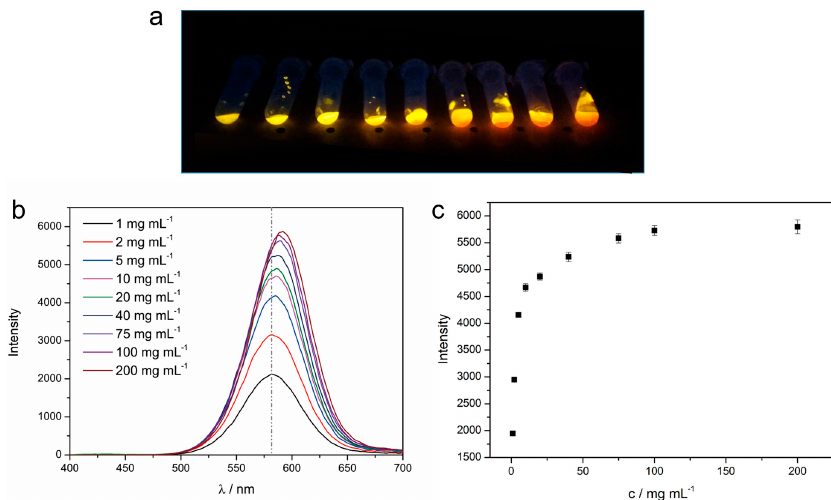
Figure 2. The relationship between fluorescence property and its concentration of HEMA-Ad/ β CD- CdTe. ( a ) Photograph of HEMA-Ad@ β CD-CdTe under ultraviolet light ( λ ex = 365 nm) with different concentrations (from left to right: 1/2/5/10/20/40/75/100/200 mg/mL); ( b ) fluorescence spectra of HEMA-Ad@ β CD-CdTe with different concentrations ( λ ex = 380 nm); and ( c ) MFI scatterplot of HEMA- Ad@ β CD-CdTe with different concentrations.